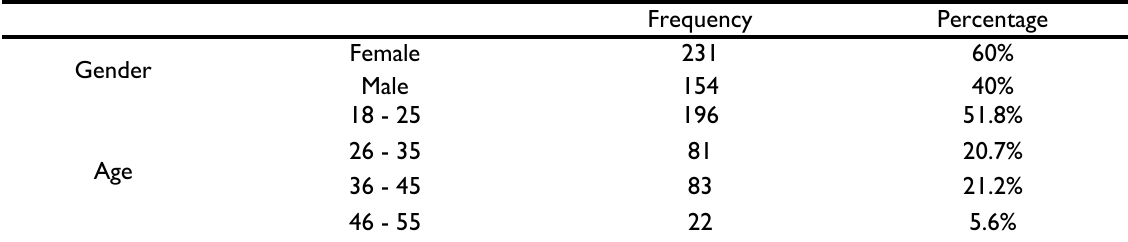
Table 1. Characteristics of